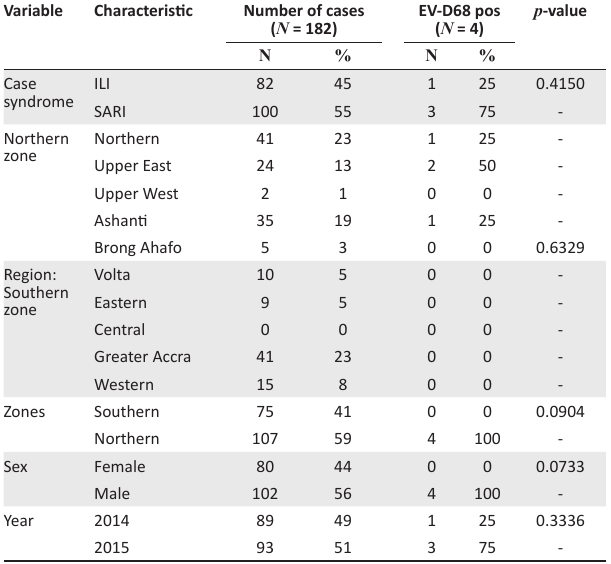
TABLE 2: Demographic characteristics of patients screened for enterovirus